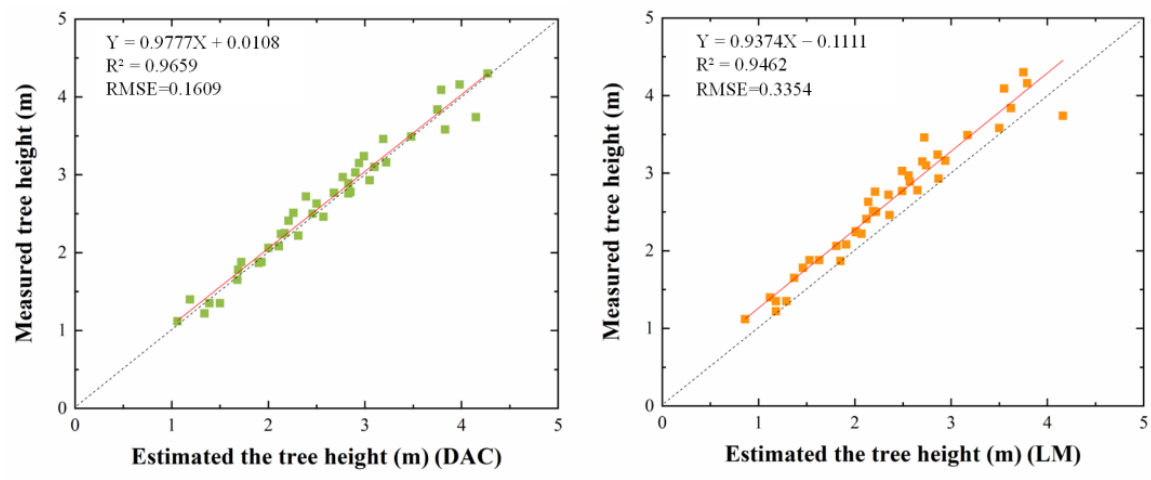
Figure 10. Tree height accuracy verification; the green points are the verification results of DAC in 2021; the orange points are the verification results of LM in 2021.